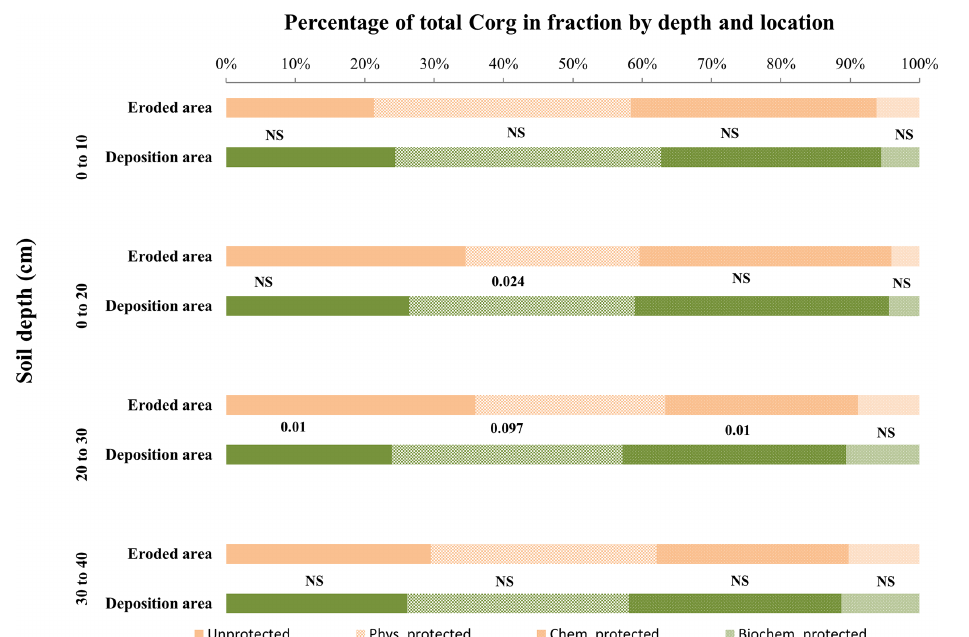
Figure 6. Fraction of total organic carbon stored in the different fractions by depth, comparing the reference site vs. the olive orchard. The labels of each fraction and depth are the p value according to a one-way ANOVA comparing the reference area vs. the olive orchard for the same carbon fraction and soil